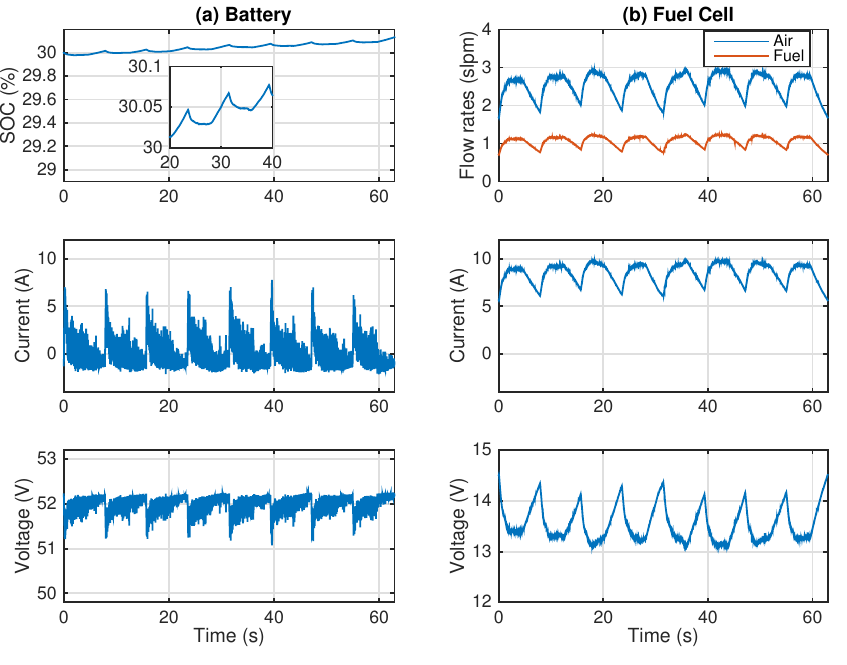
Figure 22. Low-SOC semi-active hybrid simulation. ( a ) Battery response and ( b ) FC